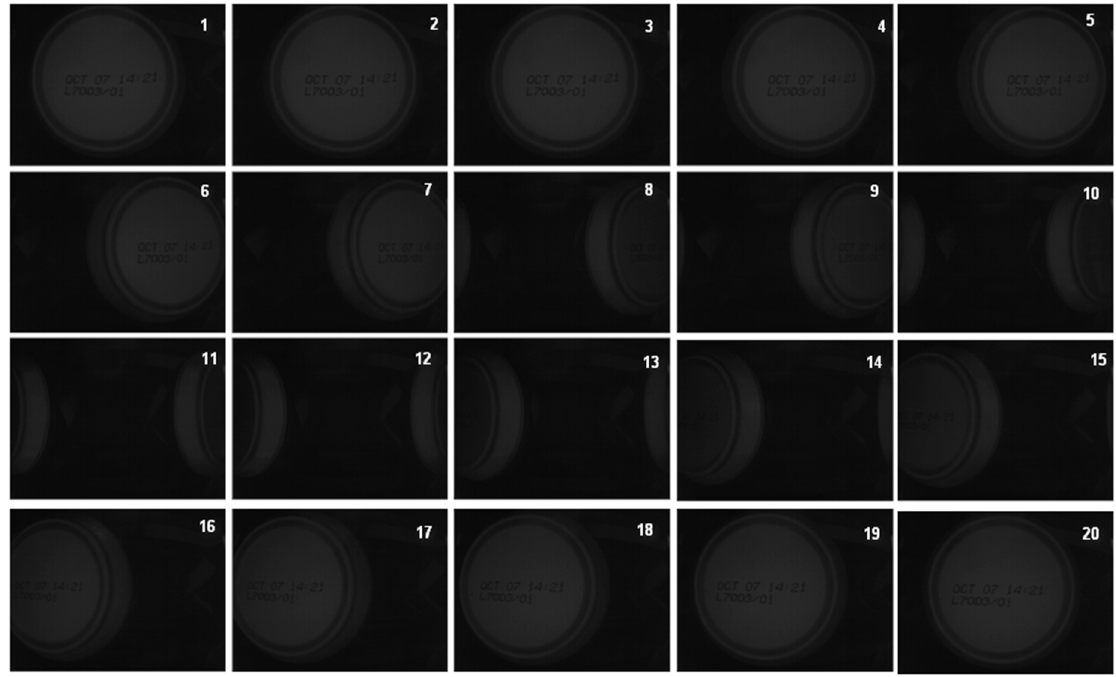
Figure 3. Acquisition during the transit of one can at 200 fps captures 20 frames. From left to right and top to bottom, a can in frames 1 to 10 leaves the field of view by the right side, while another can enters from the left in frames 10–20. Frames 5–15 are inadequate for validation.